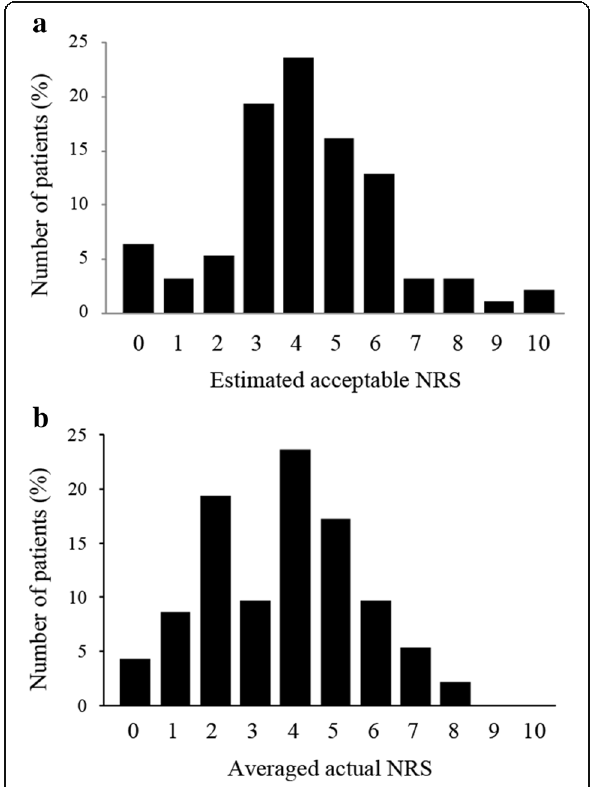
Fig. 1 Numeric rating scale (NRS) scores of postoperative pain and patient satisfaction. a Distribution of estimated acceptable postoperative pain intensity (NRS 0 – 10) before surgery. b Distribution of actual average postoperative pain intensity (NRS 0 – 10) after surgery